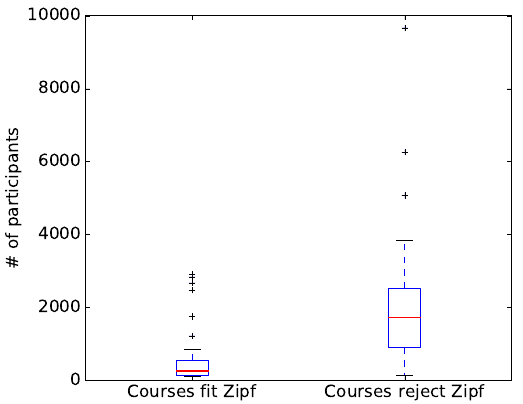
Figure 7. Number of participants for courses fitting and rejecting Zipf in the xuetangX dataset.